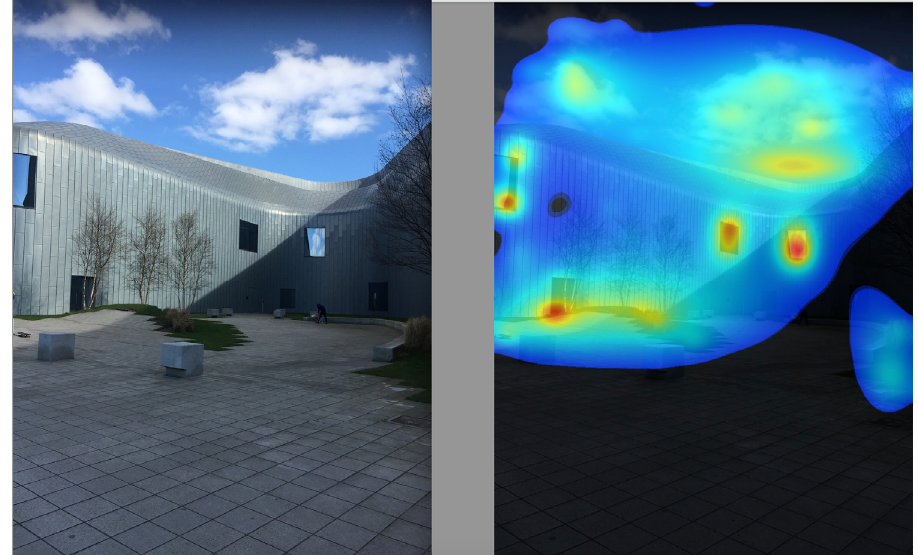
Figure 13. RSM courtyard with some vegetation. (Photo by A. Salama; VAS heatmap scan by N.A. Salingaros).